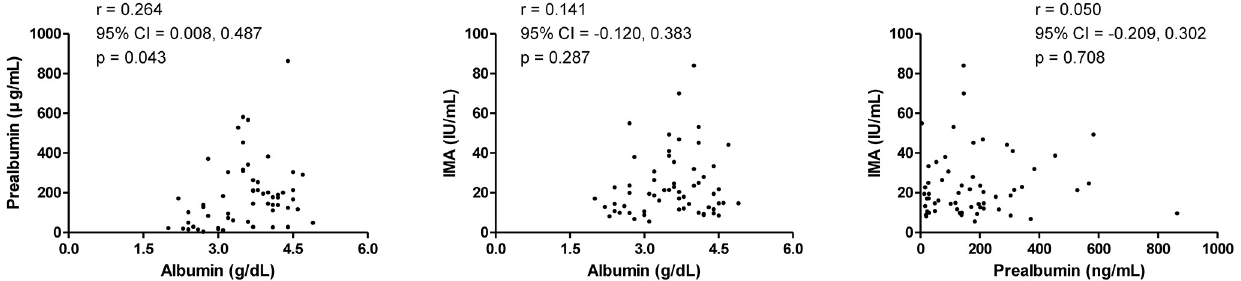
Fig 2. Relationship among baseline albumin, prealbumin, and ischemia-modified albumin. A significant association was found between albumin and prealbumin in patients with ANCA-associated vasculitis. ANCA: anti-neutrophil cytoplasmic antibody; IMA: ischemia-modified